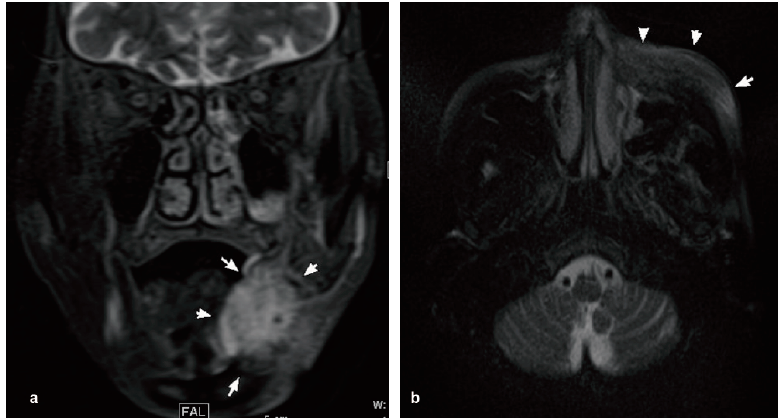
Figure 2. MRI indicated the swelling of the left submandibular tissue (arrowhead). ( a ) Coronal scan contrast T2; ( b ) Axial scan contrast T2. Diseases 2017 , 5 , 17